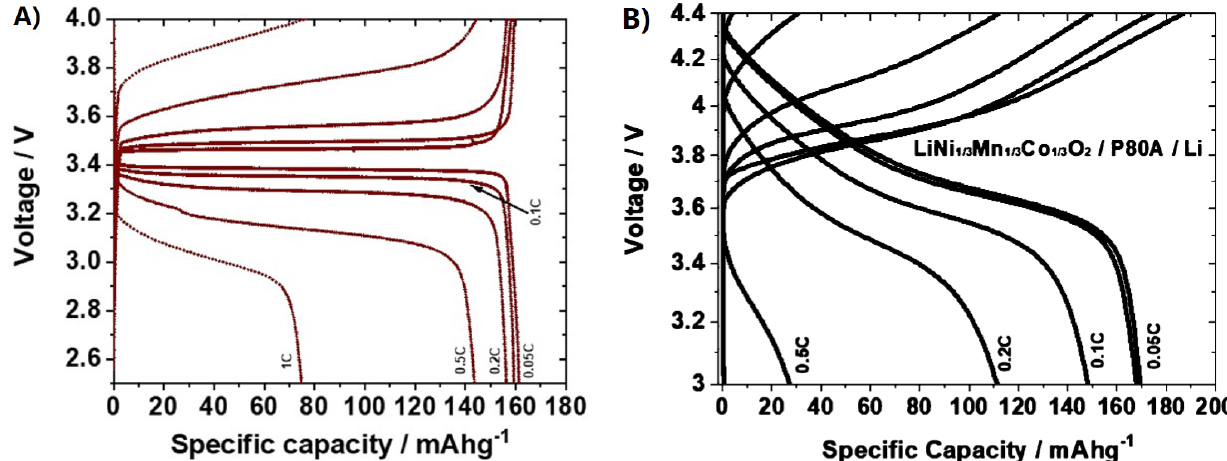
Figure 3. Specific capacity as a function of cell voltage for DGEPEG-based polymer electrolytes cycled at various rates at 60 °C with LFP ( A ) and NMC ( B ) electrodes. Chemistry of Materials, 2019.